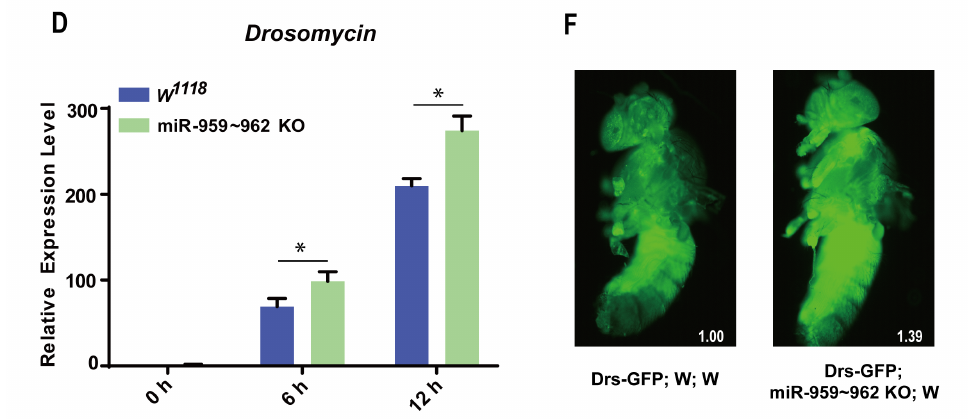
Figure 1. The miR-959–962 cluster negatively regulates Drosophila Toll-related immune response. ( A ) The changes of the survival rate were observed both in miR-959–962 cluster high-expressing flies ( Gal80 ts ; Tub > UAS-miR-959 – 962 ) and the control ( Gal80 ts ; Tub-Gal4/+ ) flies with E. faecalis infection. ( B ) The changes of the survival rate were observed both in miR-959–962 knock-out flies ( miR-959–962 KO ) and the control ( w 1118 ) flies upon E. faecalis infection. The expression levels of AMP Drs were examined in miR-959 – 962 cluster high-expressing flies ( C ) and miR-959 – 962 knock-out flies ( D ) at 0, 6 and 12 h upon M. luteus infection. ( E ) The green-fluorescent in miR-959 – 962 cluster high-expressing flies ( Drs-GFP; Gal80 ts ; Tub > UAS-miR-959–962 , right) and the controls ( Drs-GFP; Gal80 ts ; Tub-Gal4/+ , left) carrying with Drs-GFP reporter gene were observed under fluorescent microscope following infection with M. luteus . ( F ) The green-fluorescent in miR-959 – 962 cluster knock-out flies ( Drs-GFP; miR-959–962 KO; w , right) and the controls ( Drs-GFP; w; w , left) carrying with Drs-GFP reporter gene were observed under fluorescent microscope following infection with M. luteus . The levels of GFP were quantified using Image J software with the default parameters and their relative level values were marked in the bottom right corner of the image. (* p < 0.05; ** p < 0.01; *** p <